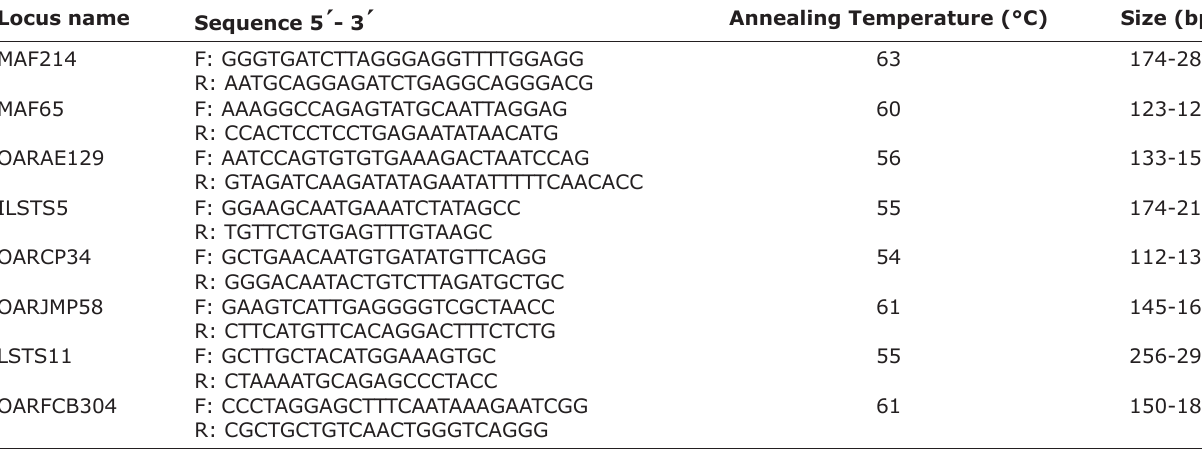
Table-1: Sequences of microsatellite marker primers, annealing temperature, and allele size. Locus